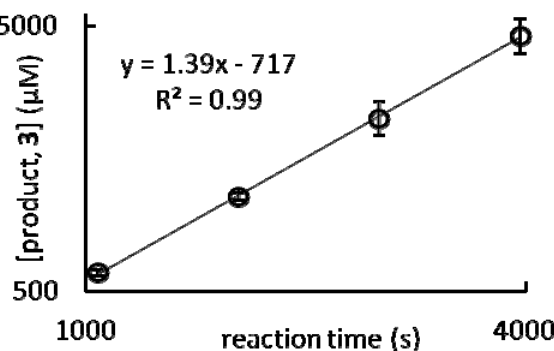
(a) or 7 mol % Eu(NO ) 3 3 3